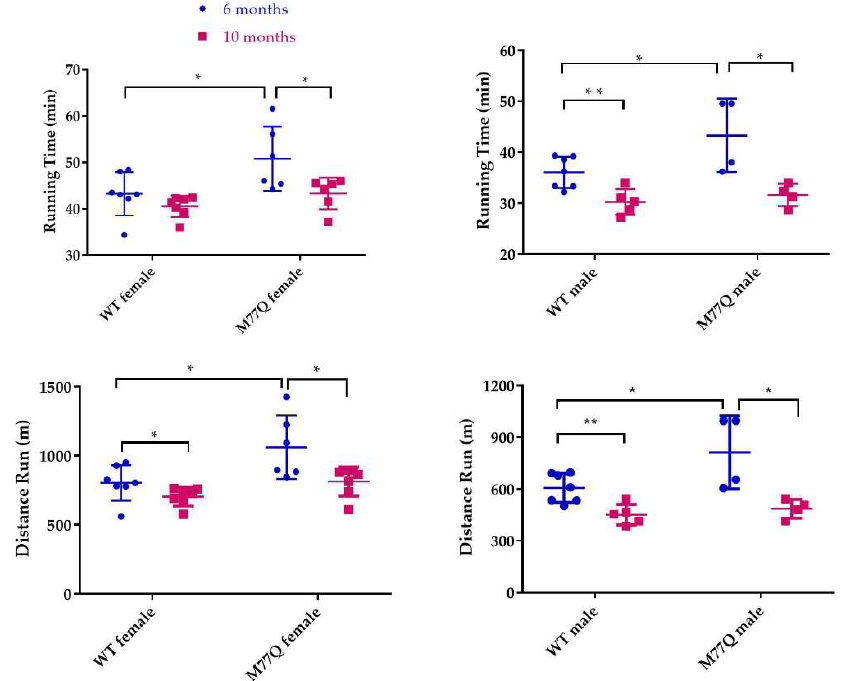
Figure 7. Treadmill test at 6 months of age. We tested 7 wild type and 4 M77Q males and 11 wild type and 8 M77Q females. The results from 1 M77Q were omitted as an outlier because they were greater than 3 standard deviations from the mean of the group. An asterisk marks the M77Q mice that differed significantly from the wild type (* p < 0.05 by t -test).